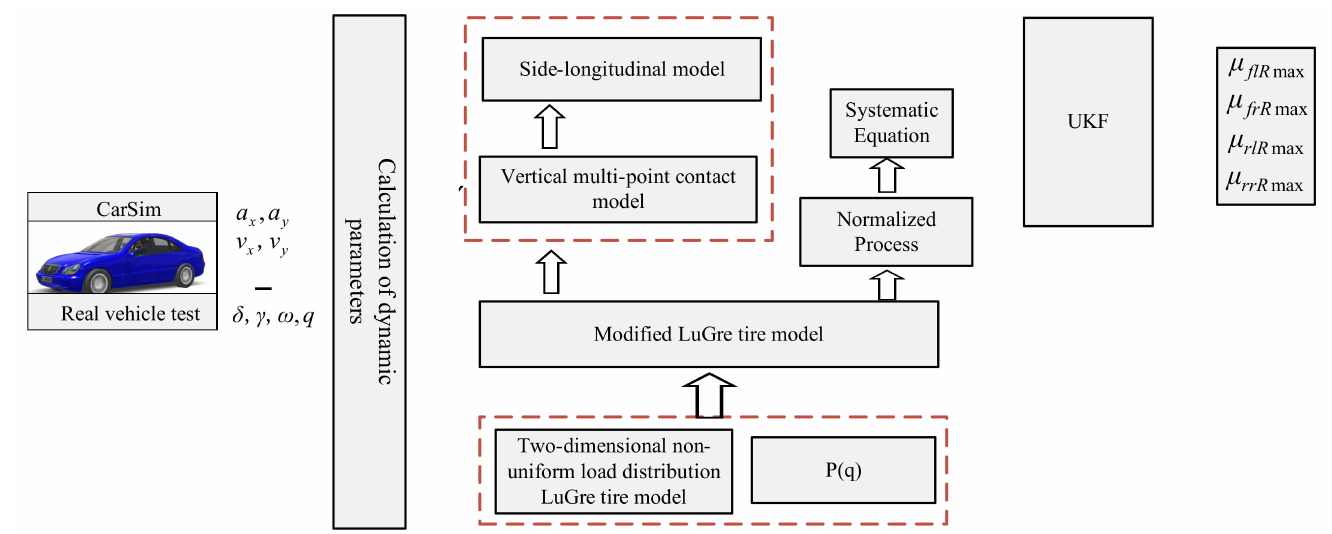
Figure 1. Estimation flowchart for TRPFC.